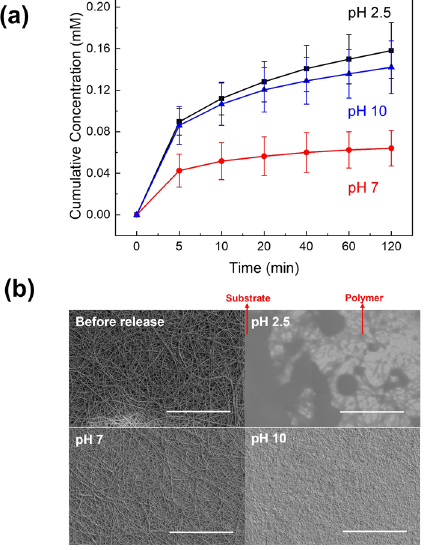
Fig. 2 Release by Ce(NO 3 ) 3 -loaded nano fi bers at different pH conditions. a Cumulative release pro fi les of Ce(NO 3 ) 3 -loaded nano fi bers in DI water with varied pH. b The surface morphology of Ce(NO 3 ) 3 -loaded nano fi bers before and after the release study. The release study was performed for 2 h. Scale bar is 50